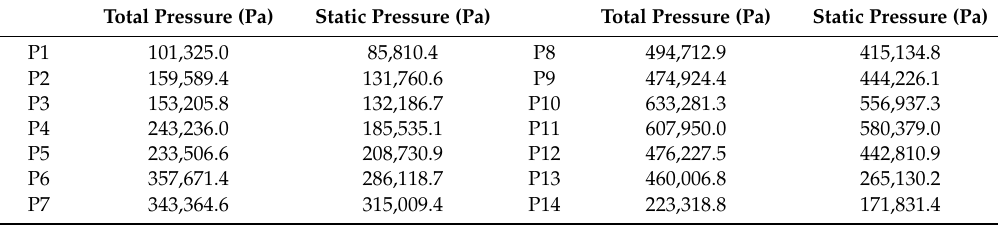
Table 4. Heat transfer coefficients used in the computational simulations.